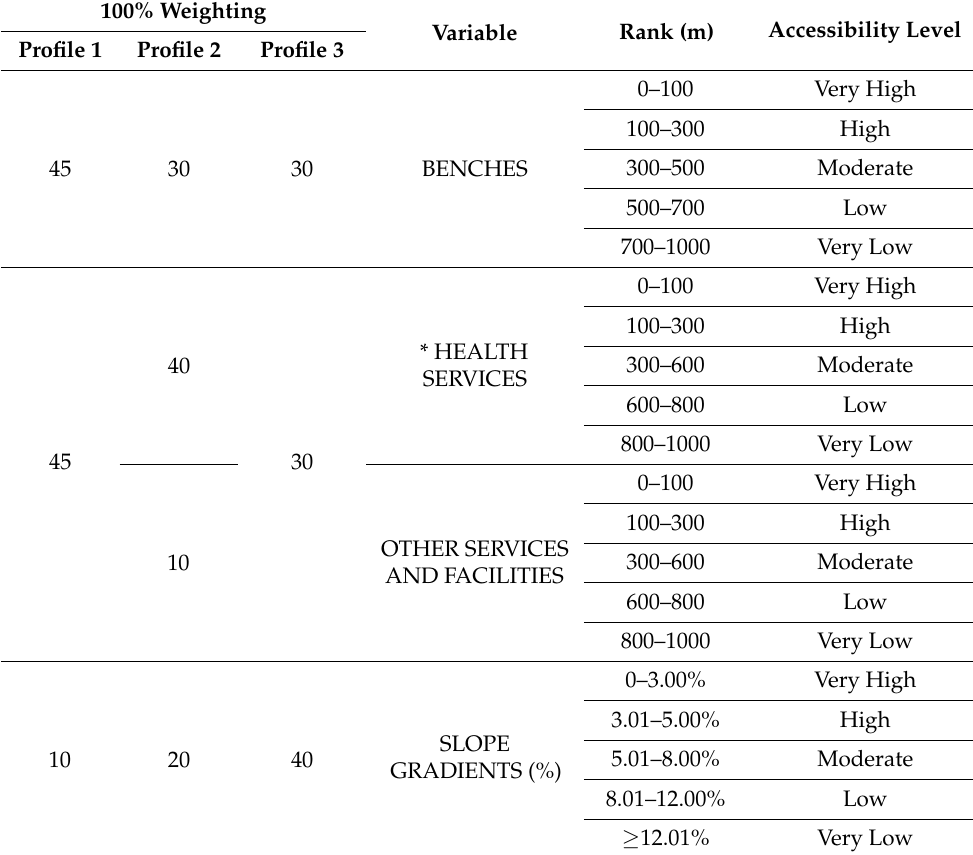
Table 2. Weightings for calculating accessibility levels for each older adult